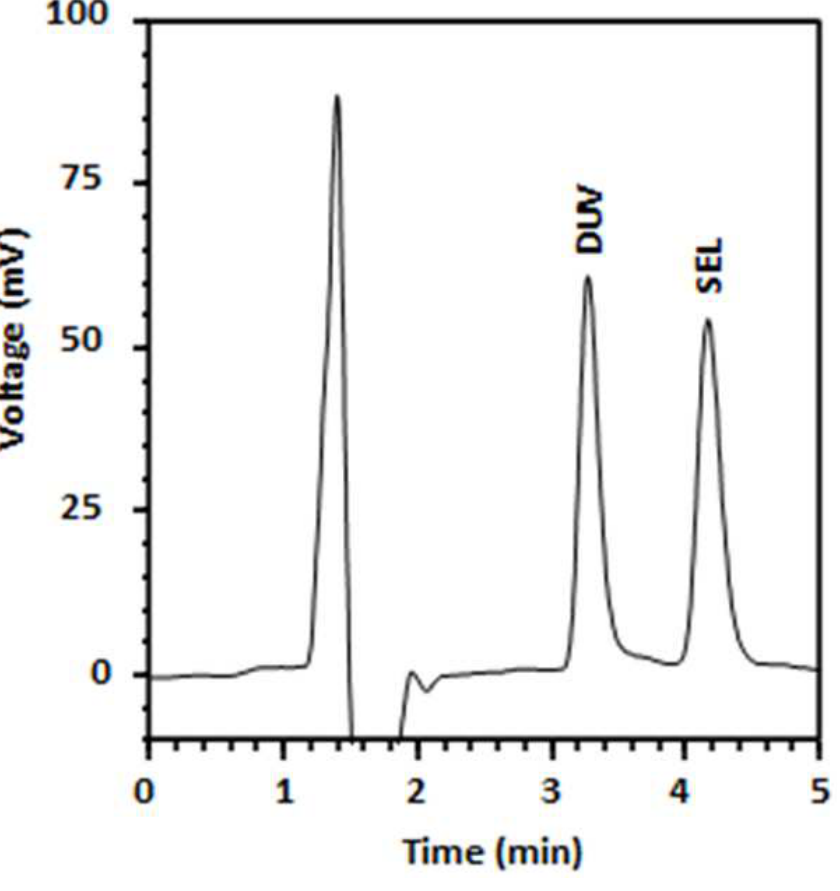
Figure 10. A representative chromatogram of standard solutions of DUV and SEL. The concentrations of DUV and SEL injected into the HPLC-FD system were 1.6 and 0.8 µ g/mL, respectively. Both solutions were in methanol.